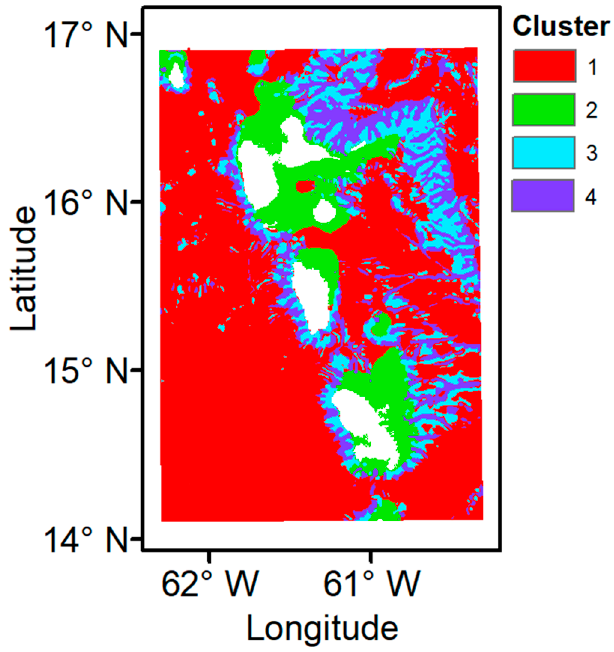
Figure 7. Broadscale Landscape Map for the larger study area, using four eigenvalues. Showing the K-means cluster analysis results of the five cluster classes.